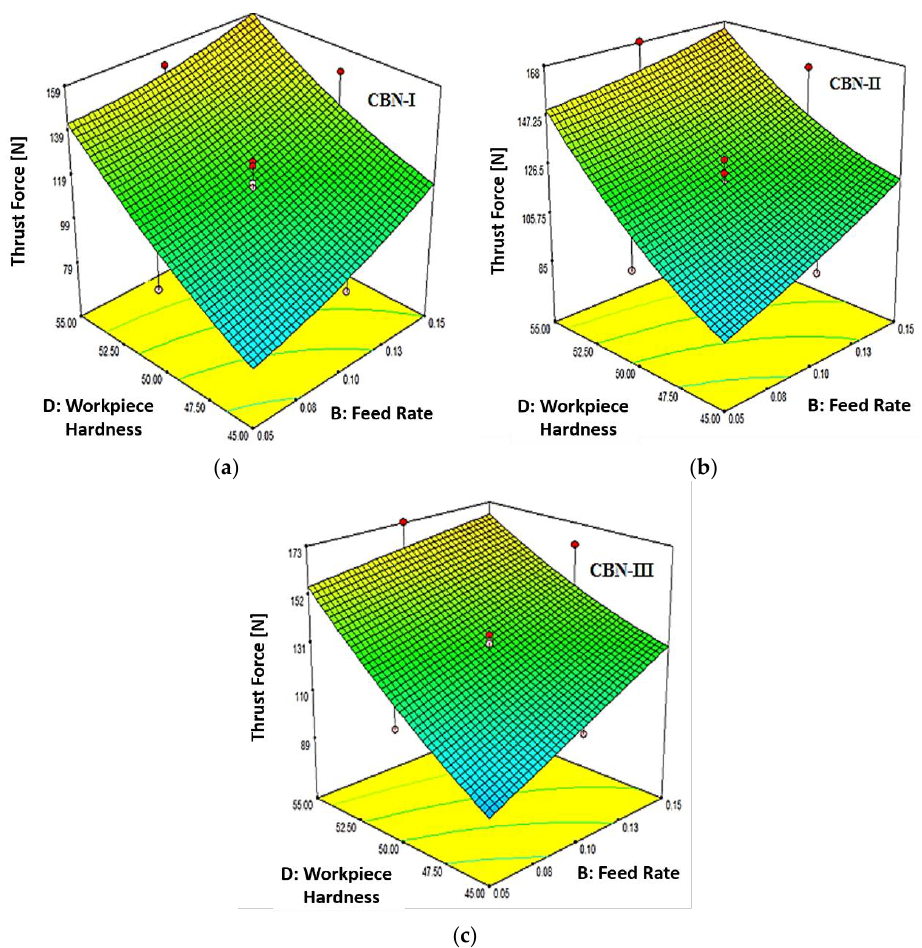
Figure 8. ( a ) Effect of Work Material Hardness (D) and Feed Rate (B) on Thrust Force (Ft) for CBN-I Insert; ( b ) Effect of Work Material Hardness (D) and Feed Rate (B) on Thrust Force (Ft) for CBN-II Insert; ( c ) Effect of Work Material Hardness (D) and Feed Rate (B) on Thrust Force (Ft) for CBN-III Insert. Materials 2019 , 12 FOR PEER REVIEW